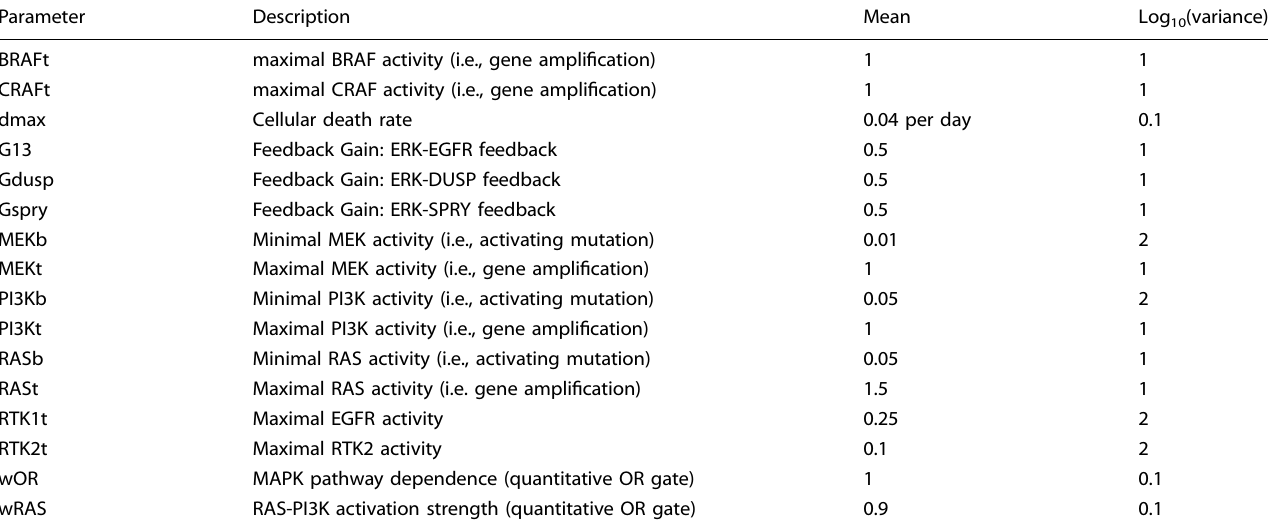
Table 2. Model parameters selected for variation across the virtual population Parameter